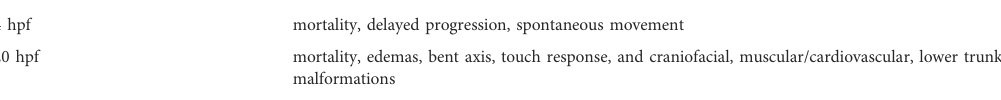
TABLE 1 All zebra fi sh morphological endpoints, including mortality, measured at 24 and 120 h post-fertilization (hpf). Zebra fi sh Morphological Endpoints 24